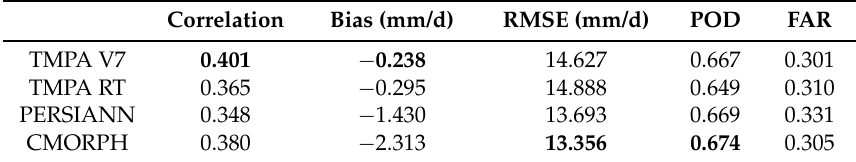
Table 4. Statistical validation between in situ and satellite datasets. Values were averaged overall all stations and the entire period (from 1 January 2001 and 30 December 2012). The best scores are shown in bold. Correlation Bias (mm/d) RMSE (mm/d) POD